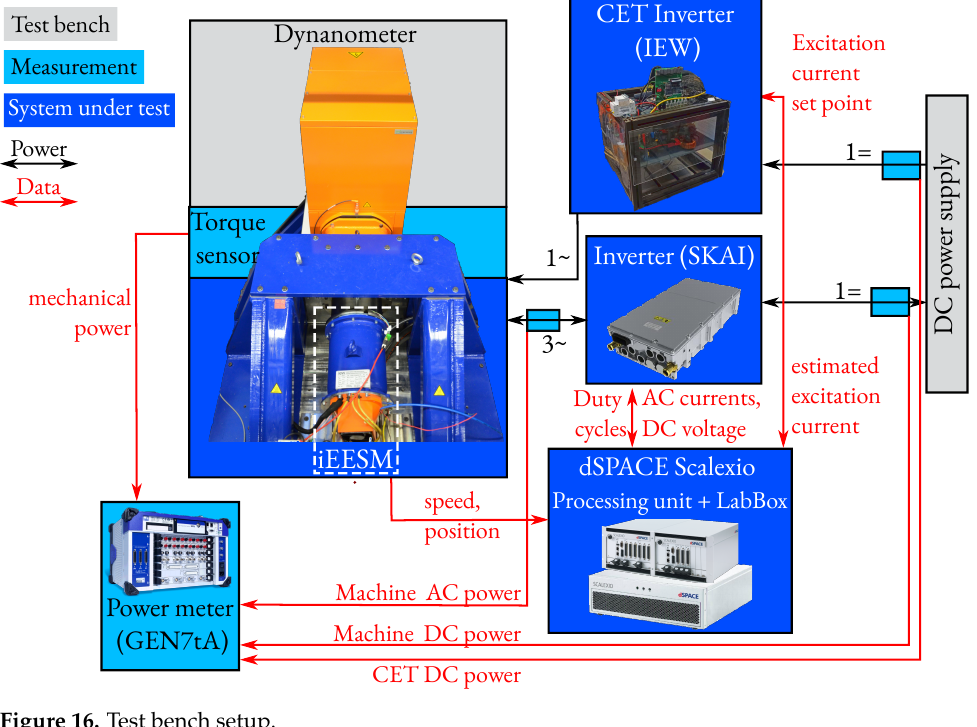
Figure 16. Test bench